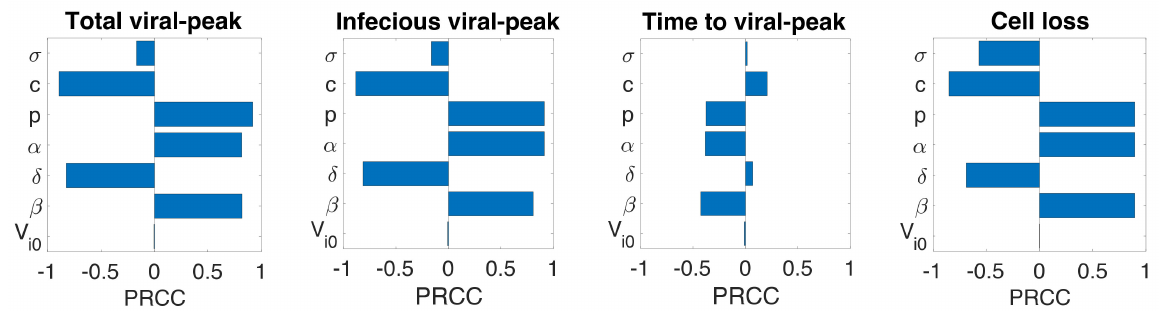
Figure 4. Sensitivity analysis. Partial rank correlation coefficients (PRCC) from the Latin hypercube sampling method of the total viral-peak size ( 1st column ), infectious viral peak size ( 2nd column ), time to viral-peak ( 3rd column ), and cell loss ( 4th column ) for Model 1 ( 1st row ), Model 2 ( 2nd Row ), and Model 3 ( 3rd row ).